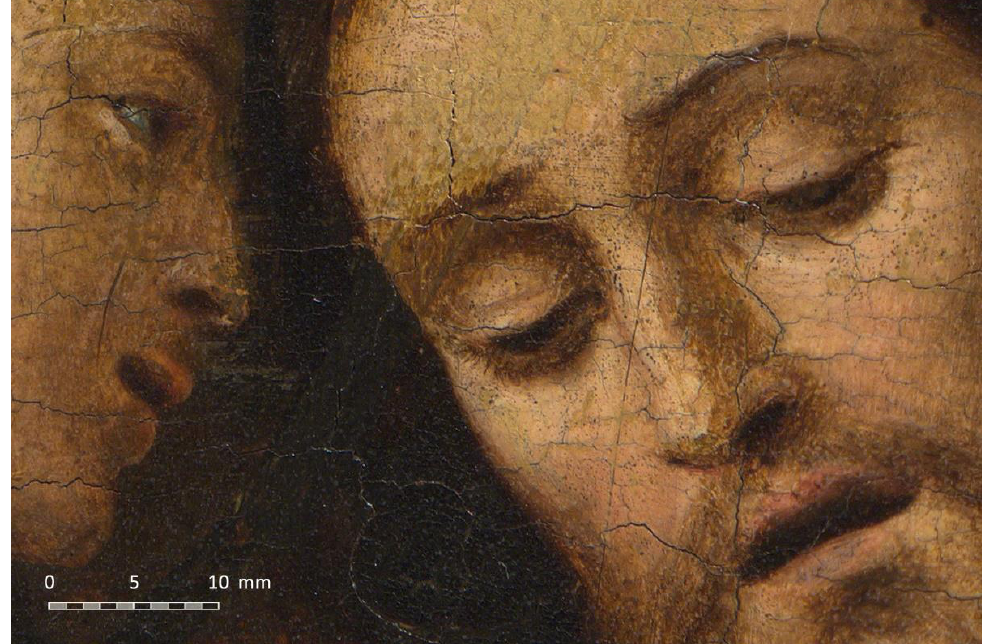
Figure 13. ( a ) Set of 90 pictures taken during the gigapixel capture. ( b ) Stitched gigapixel Image.